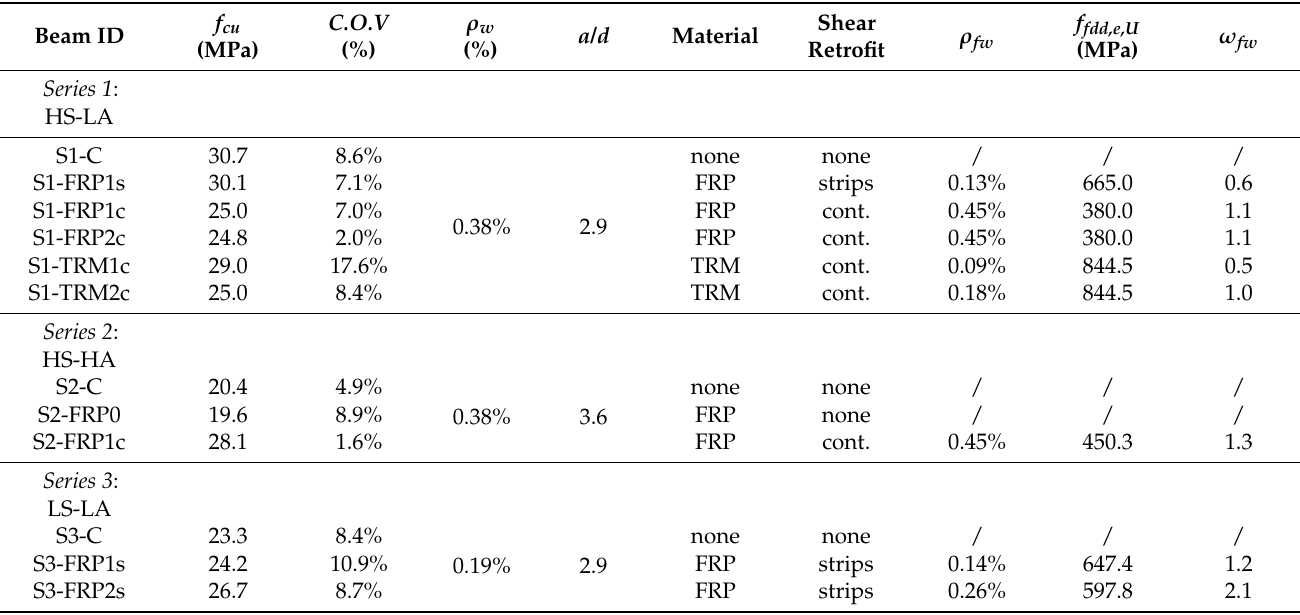
table. The steel reinforcement used consisted of Φ 10 mm longitudinal bars ( f ym = 600 MPa) and Φ 6 mm smooth transverse bars ( f ym = 470 MPa). Table 3. Experimental specimens and retrofit